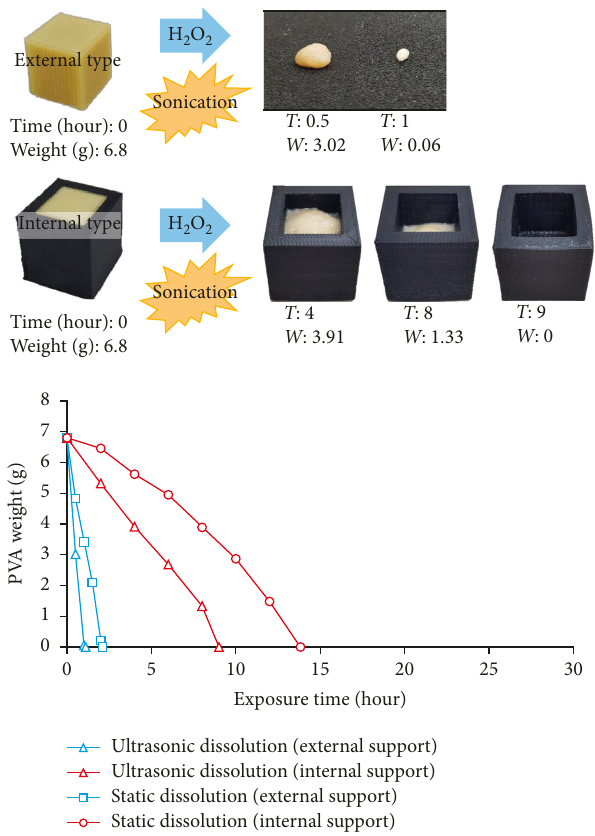
Figure 8: Dissolution rates of external- and internal-type PVA support samples in hydrogen peroxide with and without appli- cation of